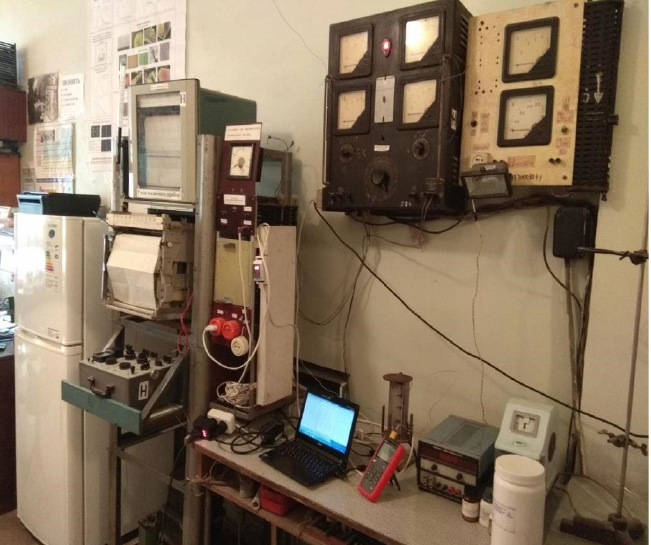
Figure 4. Experimental setup for thermography of substances using thermal analysis technique.